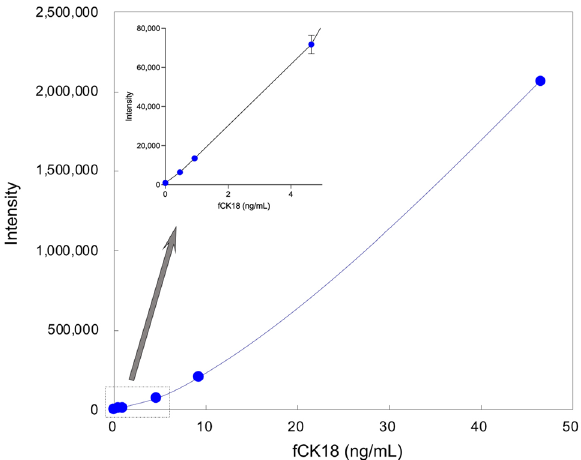
Figure 4. CLEIA for fCK18 measurement. The intensity range of fCK18 from 0.465 to 46.5 ng/mL based on our highly sensitive